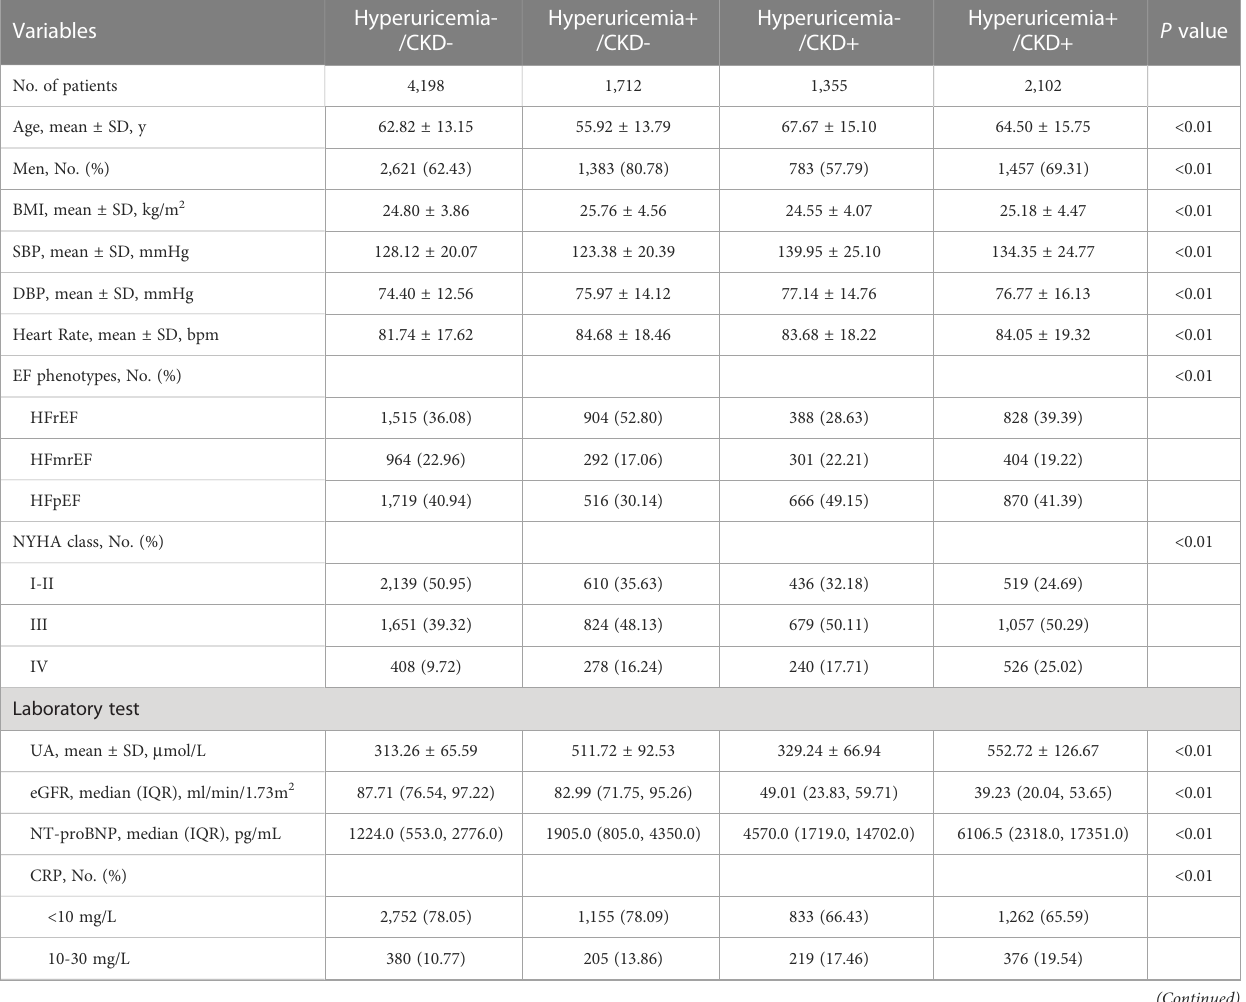
TABLE 1 Characteristics of 9,367 patients with CHF according to hyperuricemia/CKD groups. Variables